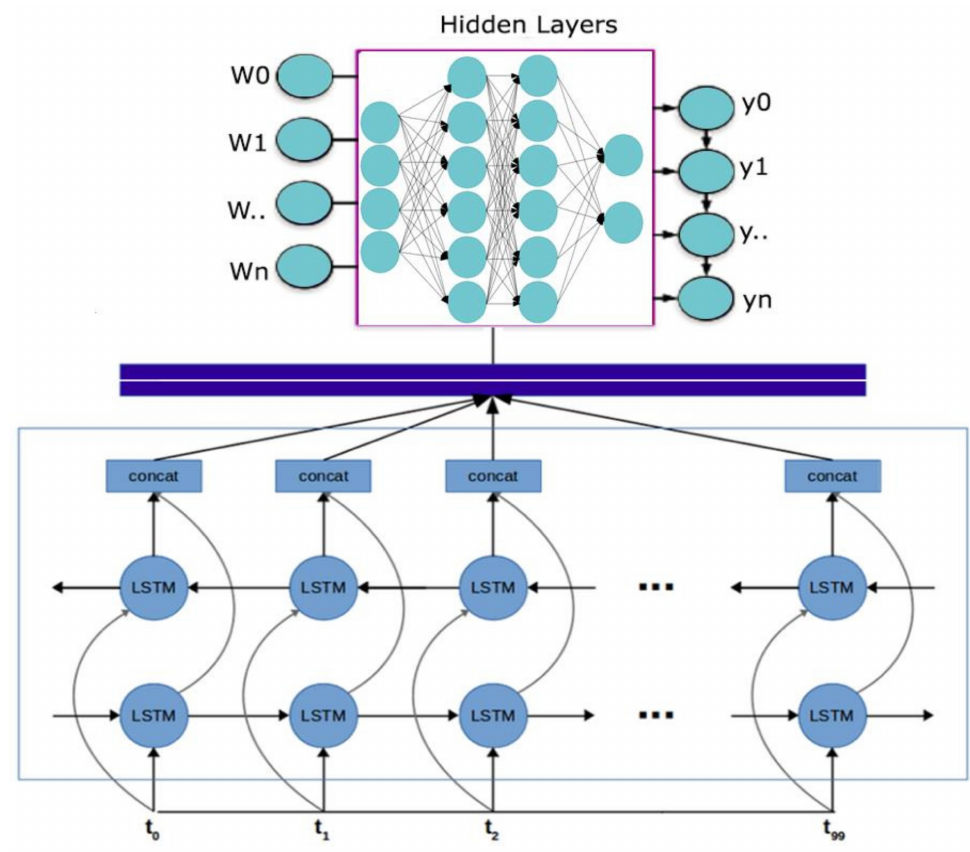
Figure 2. Enhancing Brain Tumor Diagnosis with Bidirectional Long Short-Term Memory